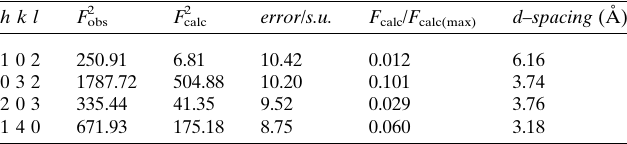
Table 1 List of the top four poorly fitting reflections for the model of the mono- selenide shown in Fig.